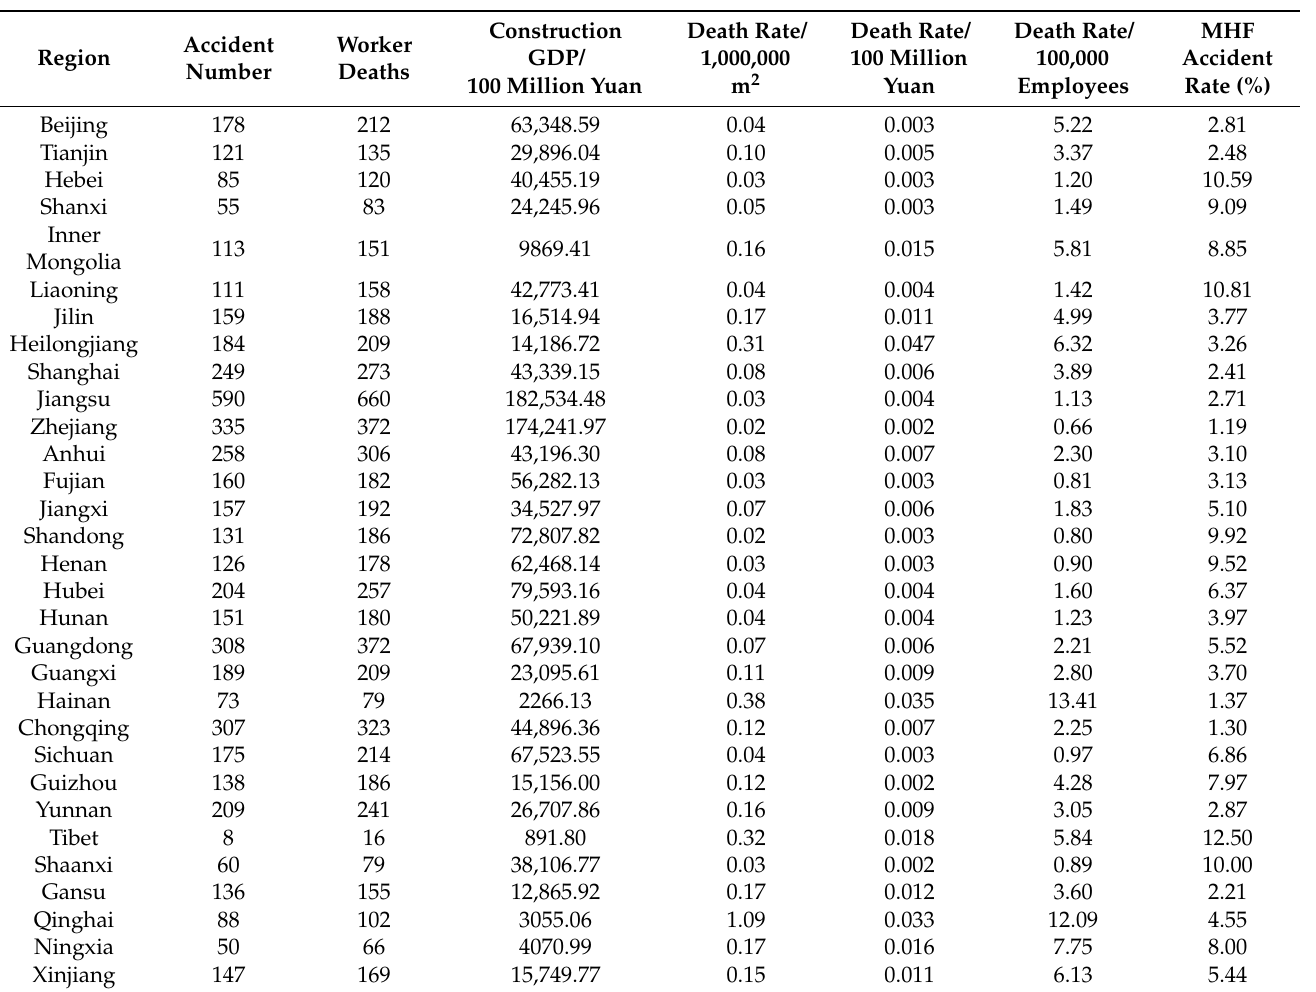
Table 2. Construction accident indices in 31